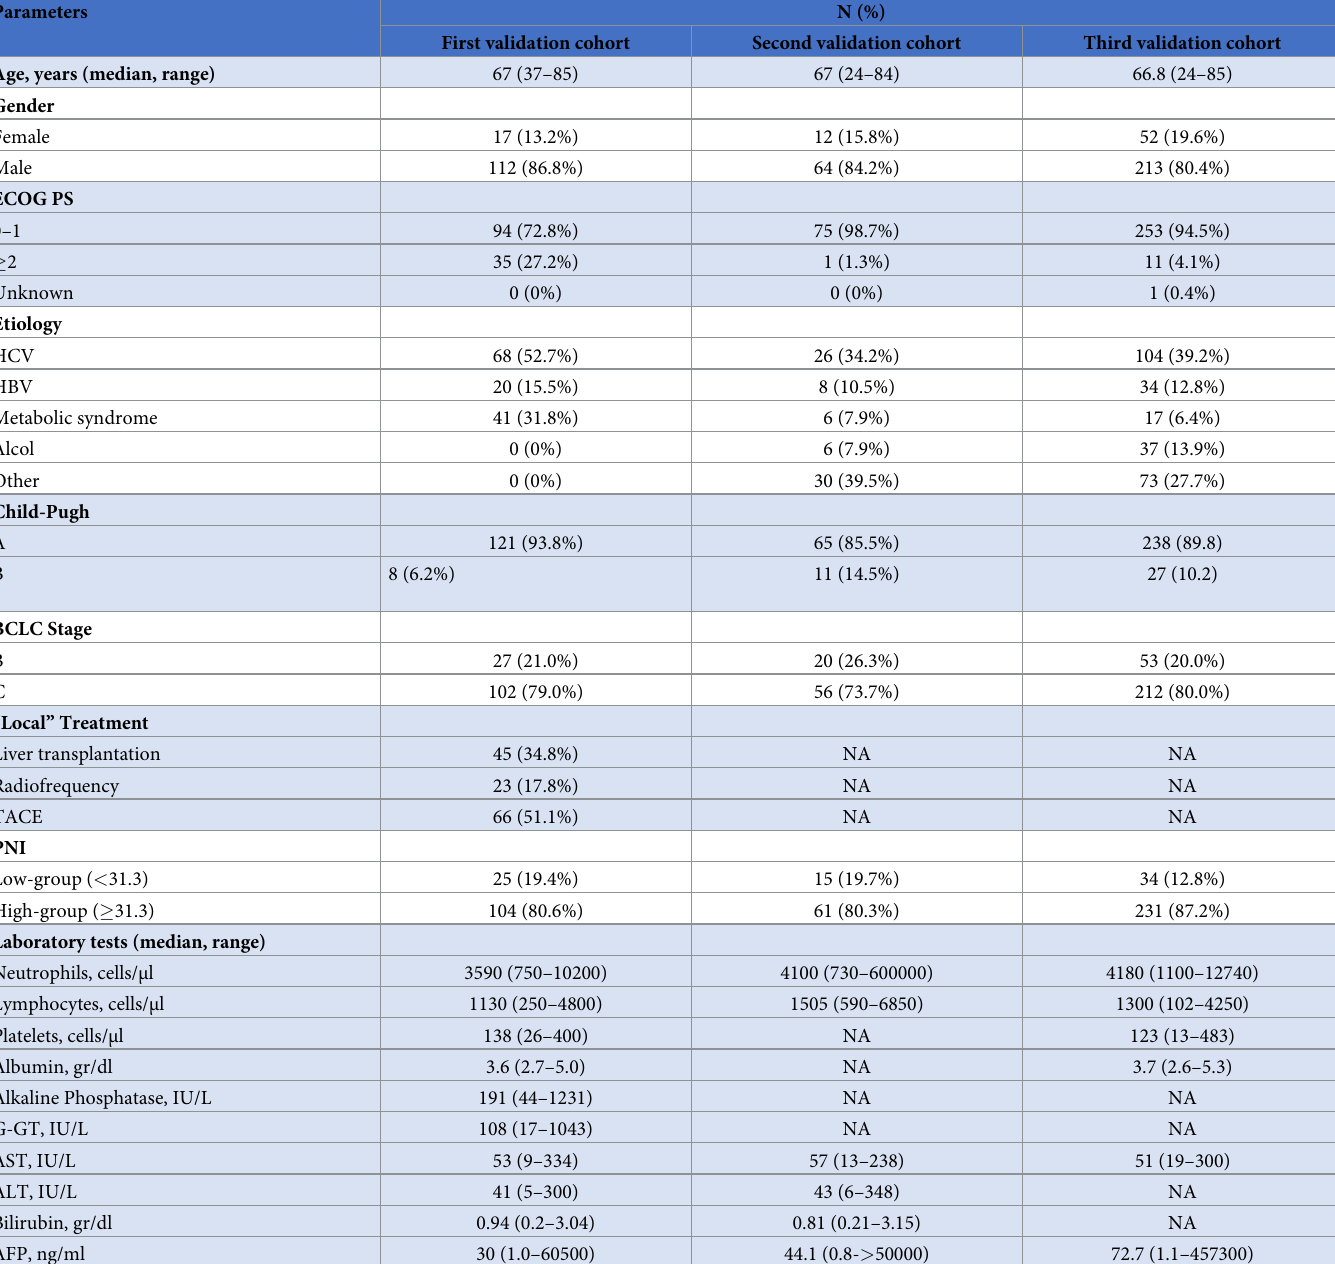
Table 3. Baseline characteristics of the first, second- and third-validation